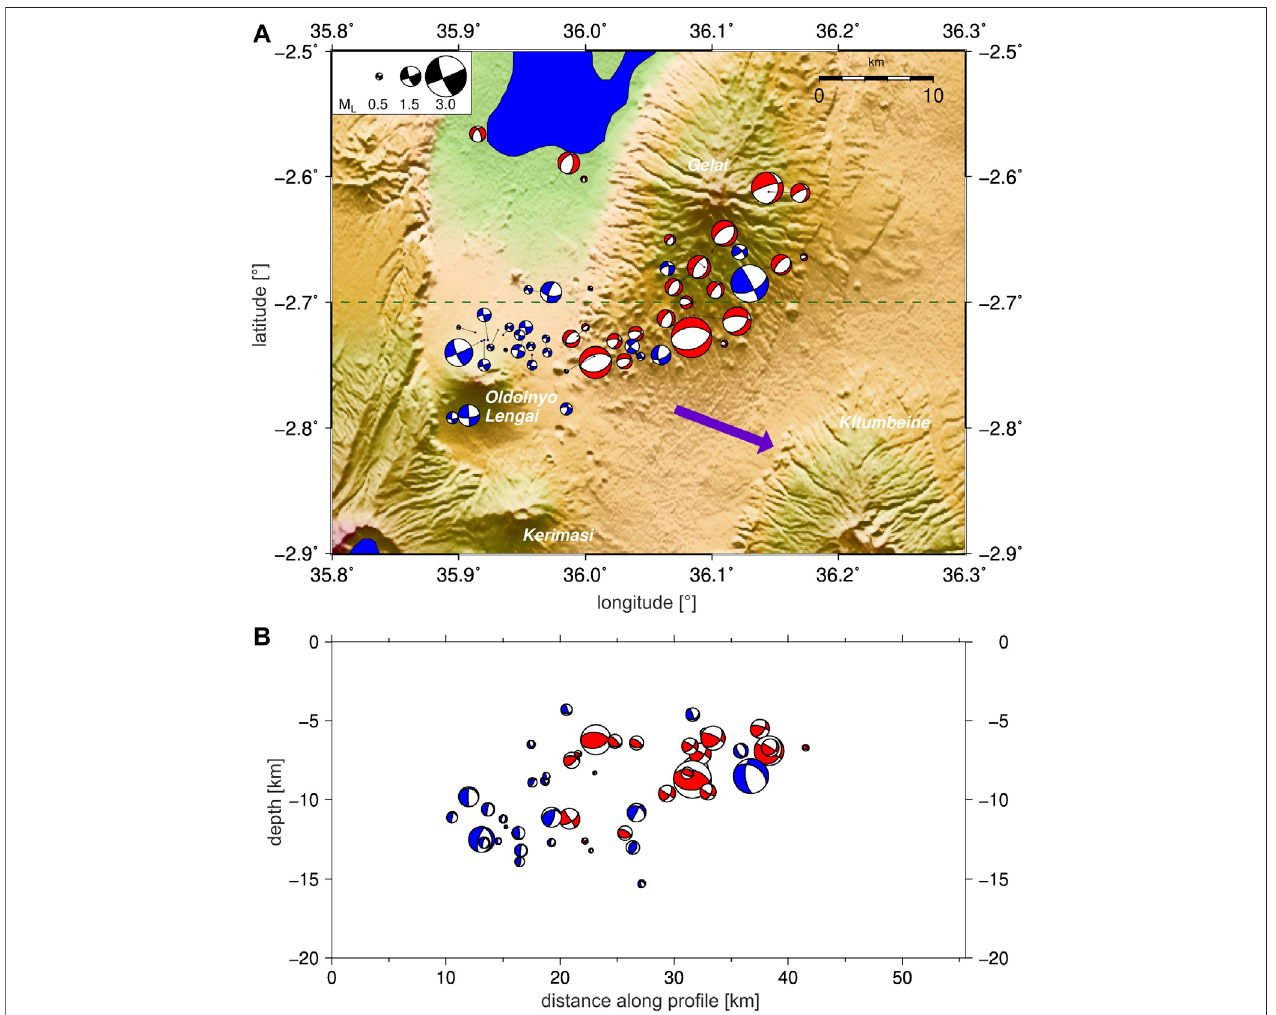
FIGURE 7 | Map and cross-section of best focal mechanisms. Blue and red beach balls show strike-slip and normal mechanisms, respectively. The size of the beach balls is given by their magnitude. (A) Map view. The green line denotes the cross-section shown in (B) . The purple vector show the GPS velocity of 1.1 mm/year from Saria et al. (2014). (B) Cross